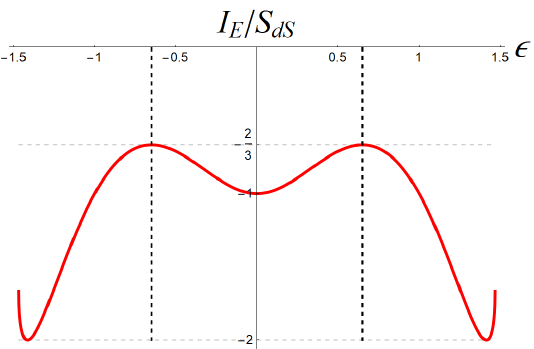
Figure 5: On-shell action I of Euclidean SdS in units of S vs. the dimension- E , SdS dS (cid:112) / L , where we have set d = 4. At ε = 0 the action 1 − r less parameter ε = ± c attains a local minimum, which corresponds to Euclidean de Sitter space S 4 , and at (cid:112) (cid:198) ε = ± 1 − 1 / 3 (dashed lines) the action attains a local maximum, corresponding (cid:112) to Euclidean Nariai space S 2 × S 2 . At | ε | = 2 the action has a global minimum which resembles pure de Sitter space, see Appendix A. There is a negative mode between the de Sitter and Nariai stationary